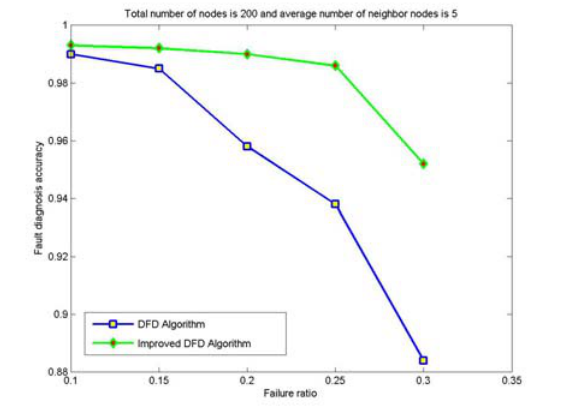
Figure 6. The node fault detection accuracy with various node failure ratios when 200 nodes are randomly deployed and the average numbers of neighbor nodes is